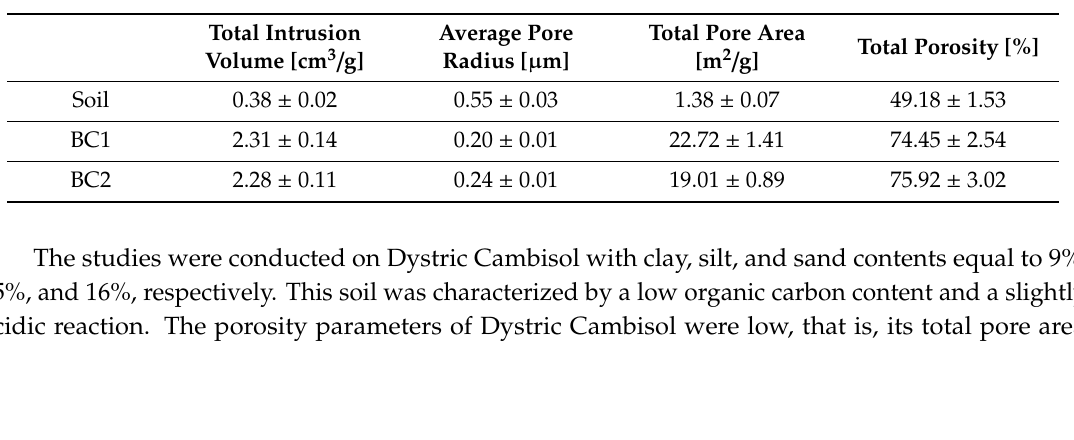
Table 2. Porosity characteristics of the soil and biochars used in cylinder